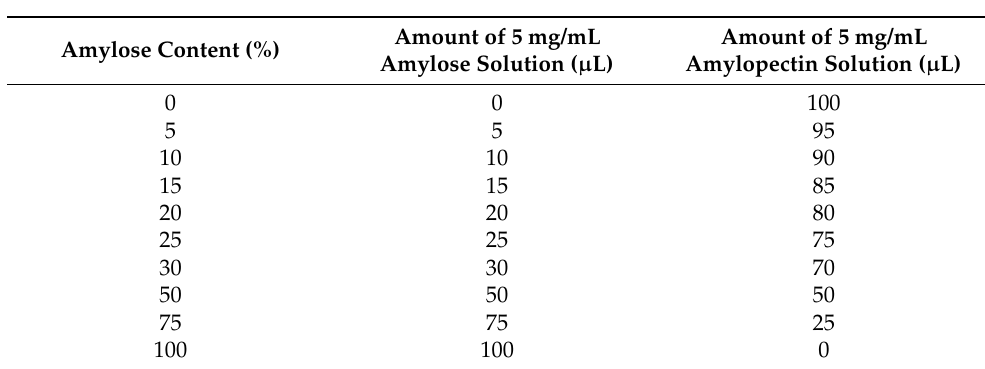
Table 4. Standard curve